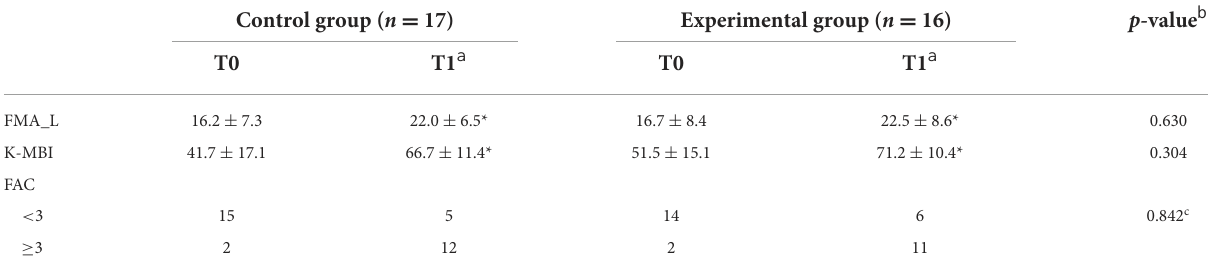
TABLE 2 Comparison of behavioral outcome indicators in control and experimental groups after 4-weeks intervention. Control group ( n = 17)